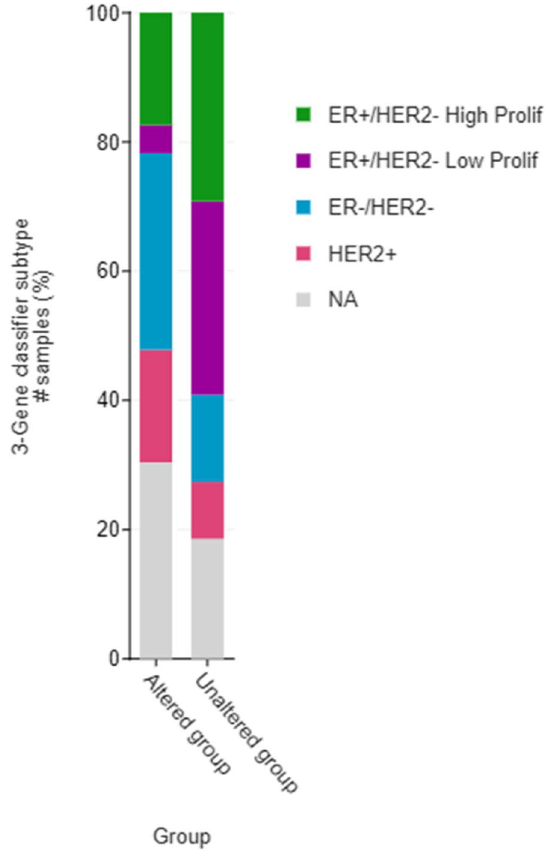
Fig. 5 METABRIC breast cancer cohort ( n